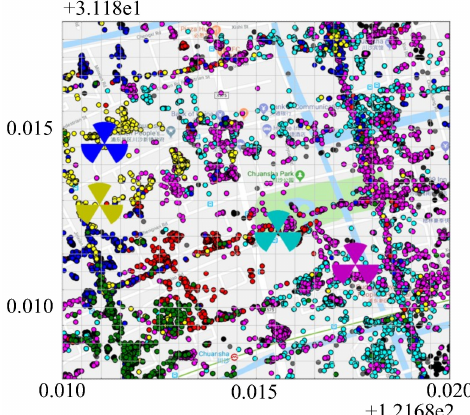
Figure 15. Scatter plot of samples of target area.